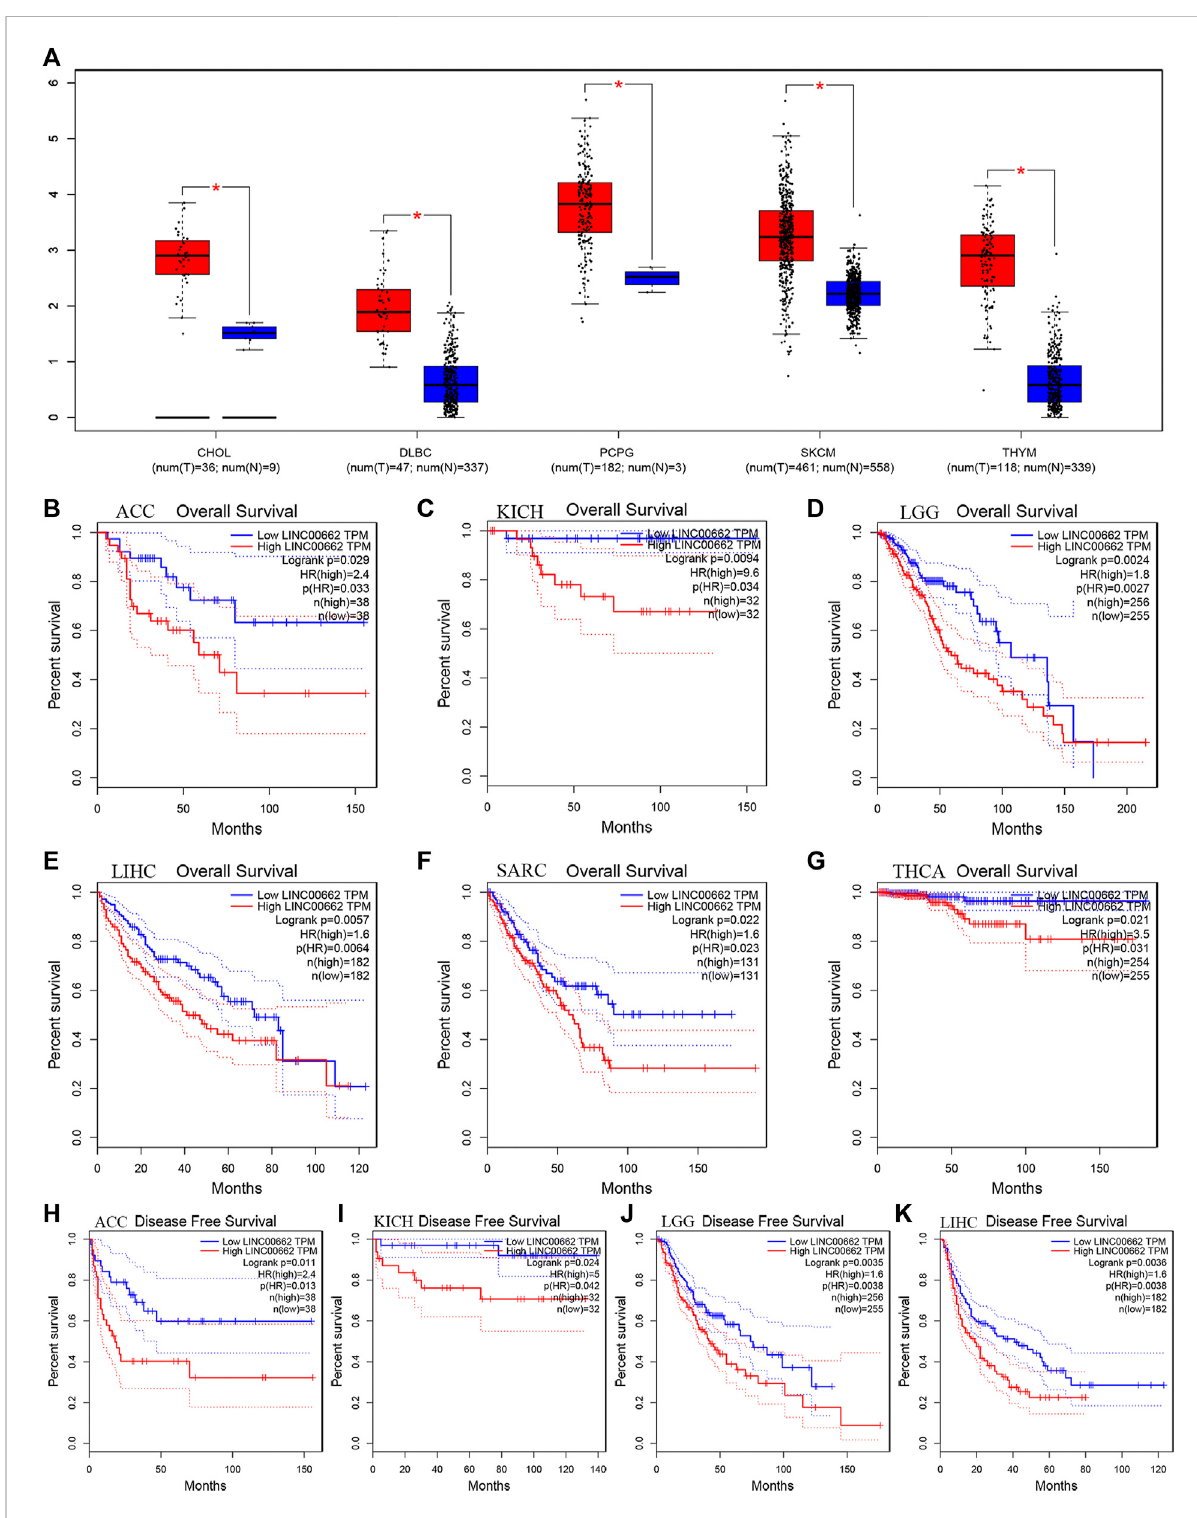
FIGURE 6 ValidationoftheroleofLINC00662inhumancancersbasedontheGEPIAcohort. (A) TheexpressionofLINC00662inhumancancers(redbox) and normal tissues (blue box) based on the TCGA and GTEx databases (|Log 2 FC| > 1 and p < 0.05). (B) OS plots of LINC00662 in ACC. (C) OS plots of LINC00662 in KICH. (D) OS plots of LINC00662 in LGG. (E) OS plots of LINC00662 in LIHC. (F) OS plots of LINC00662 in SARC. (G) OS plots of LINC00662 in THCA. (H) DFS plotsof LINC00662 in ACC. (I) DFS plots of LINC00662 in KICH. (J) DFS plots of LINC00662 in LGG. (K) DFS plots